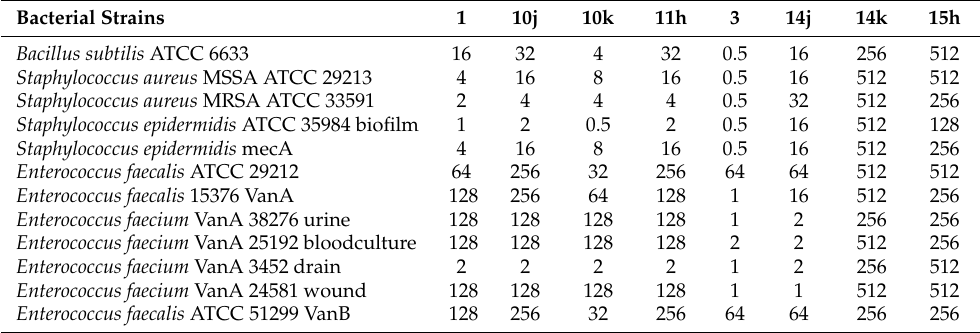
Table 1. Antibacterial effect of semisynthetic pleuromutilins based on Minimal Inhibitory Concentra- tion [28] of active compounds (MIC: mg/L) (ATCC: American Type Culture Collection, MRSA/MSSA: methicillin resistant/sensitive S. aureus , VanA and VanB: vancomycin resistant phenotypes.) Bacterial Strains Bacillus subtilis ATCC